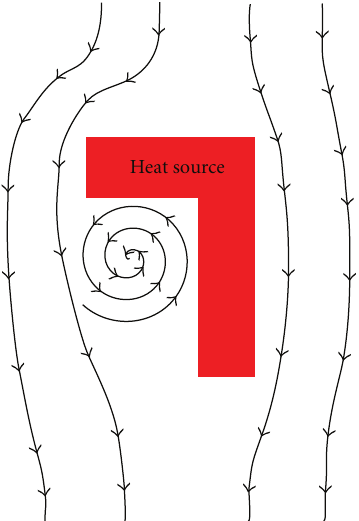
Figure 4: Schematic of fire whirl formation for an L-shaped heat source in a cross-flow wind. View is from